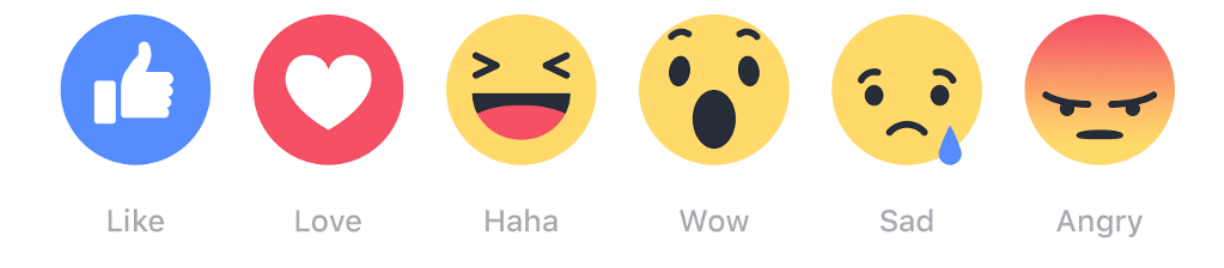
Figure 1. Facebook reaction